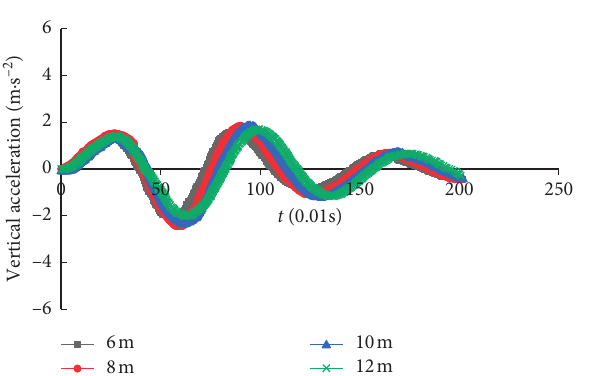
Figure 14: Vertical acceleration of testing vehicle at different slab